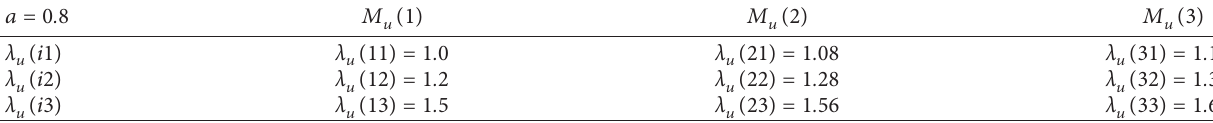
( i ) for a � 0 . 8, unit: 1/year. u